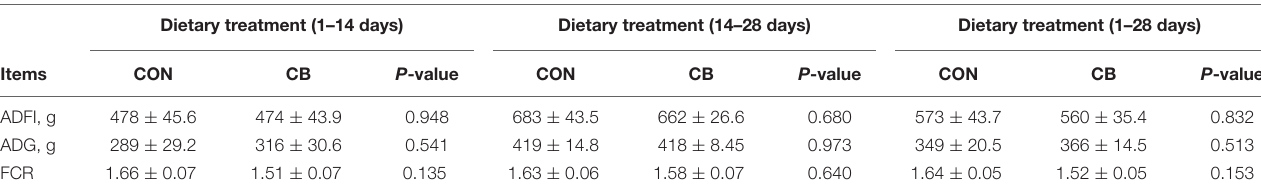
TABLE 1 | The effect of dietary corn bran on growth performance in weaned